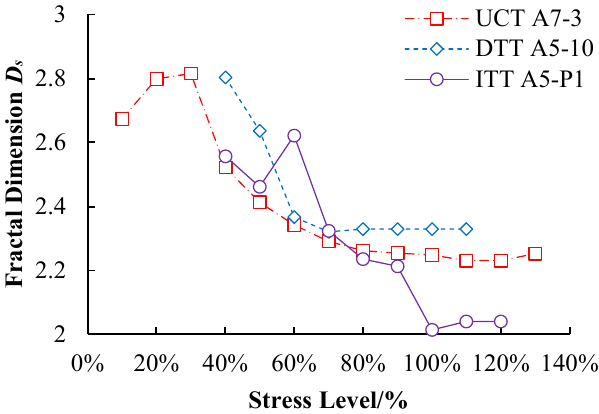
ff erent loading